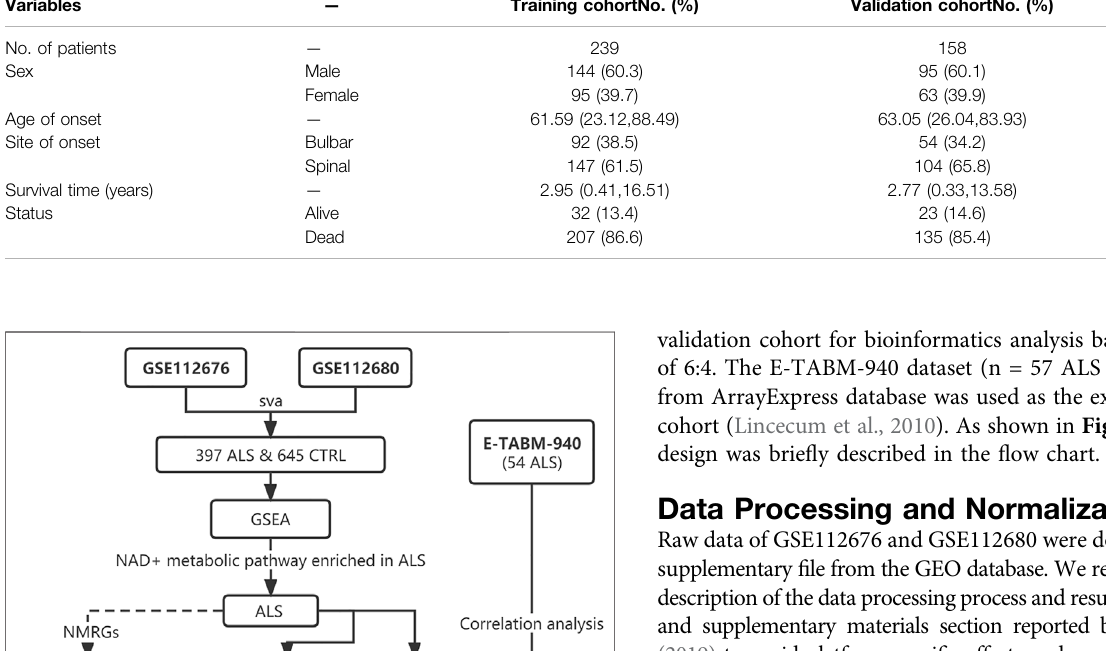
TABLE 1 | Summarization of clinicopathological features of patients in training and validation cohorts. Variables